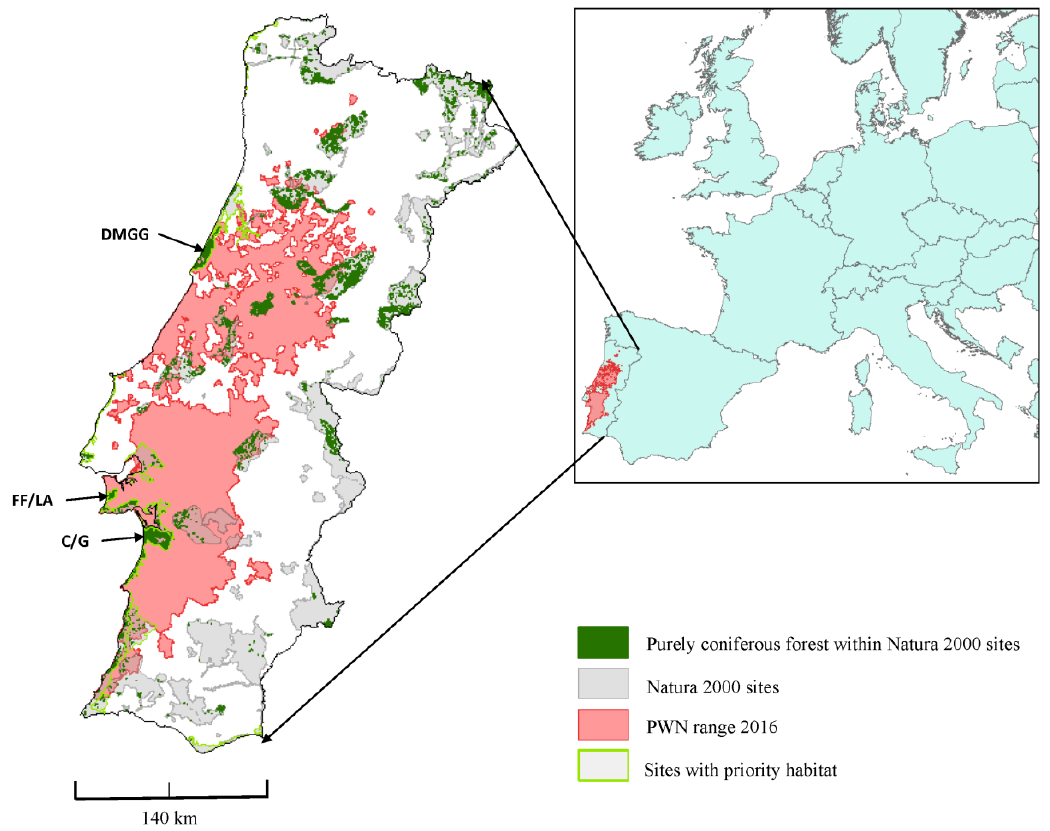
Figure 1. Natura 2000 sites, purely coniferous forest within the Natura 2000 sites, Natura 2000 sites designated to protect priority habitat of wooded dunes with Pinus pinaster and/or Pinus pinea , and pine wood nematode infected range in mainland Portugal as of October 2016. The location of the Natura 2000 sites Fernão Ferro/Lagoa Albufeira (FF/LA), Dunas de Mira, Gandara e Gafanhas (DMGG), and Comporta/Galé (C/G) is highlighted. The location of the study area (mainland Portugal) is shown in the inset map of Europe.